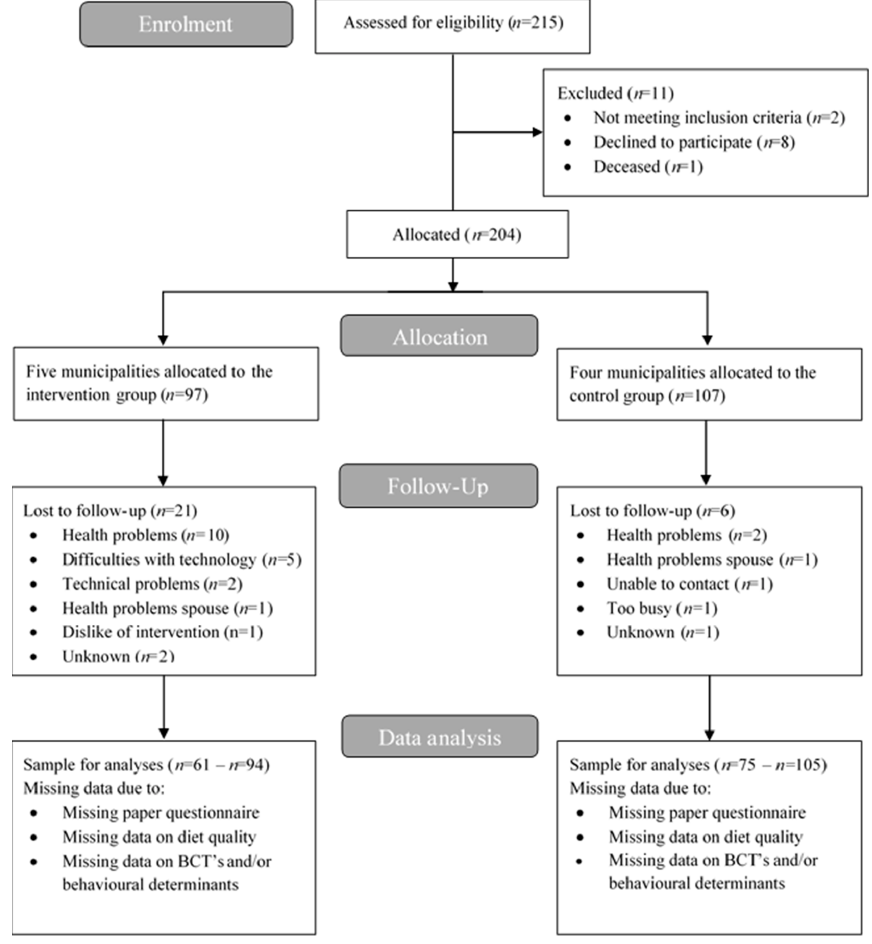
Figure 2. Flow diagram of participants of the PhysioDom HDIM study.